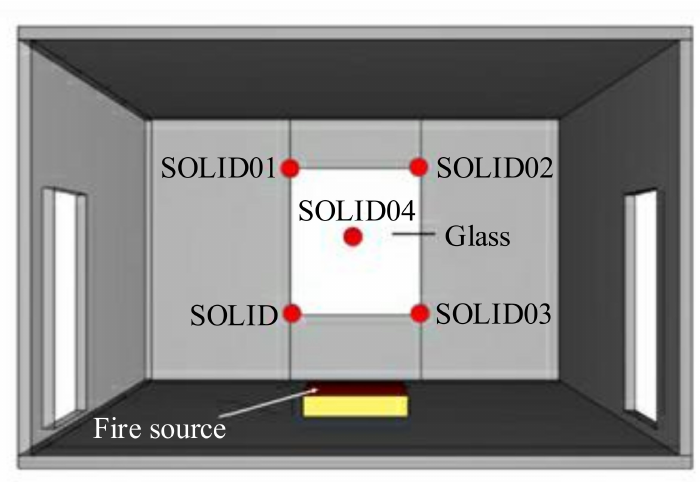
Figure 6. Layout of the temperature monitoring equipment.